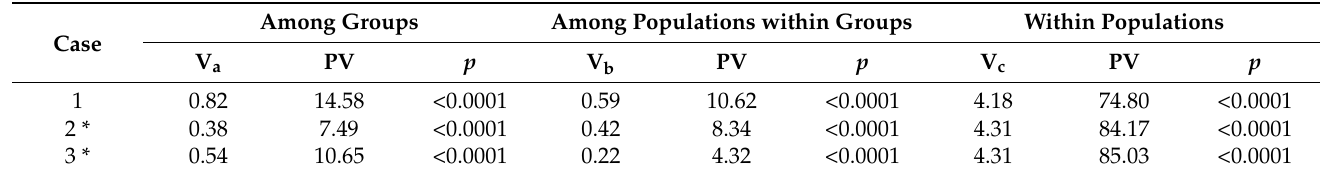
Table 2. Analysis of molecular variance (AMOVA) of 632 individuals in 31 populations of Dasineura oxycoccana in Korea and USA. Case 1: cranberry-associated versus blueberry-associated. Case 2: source (USA) versus invasive (KOR). Case 3: genetic structure-based groups (A, B, C, D,